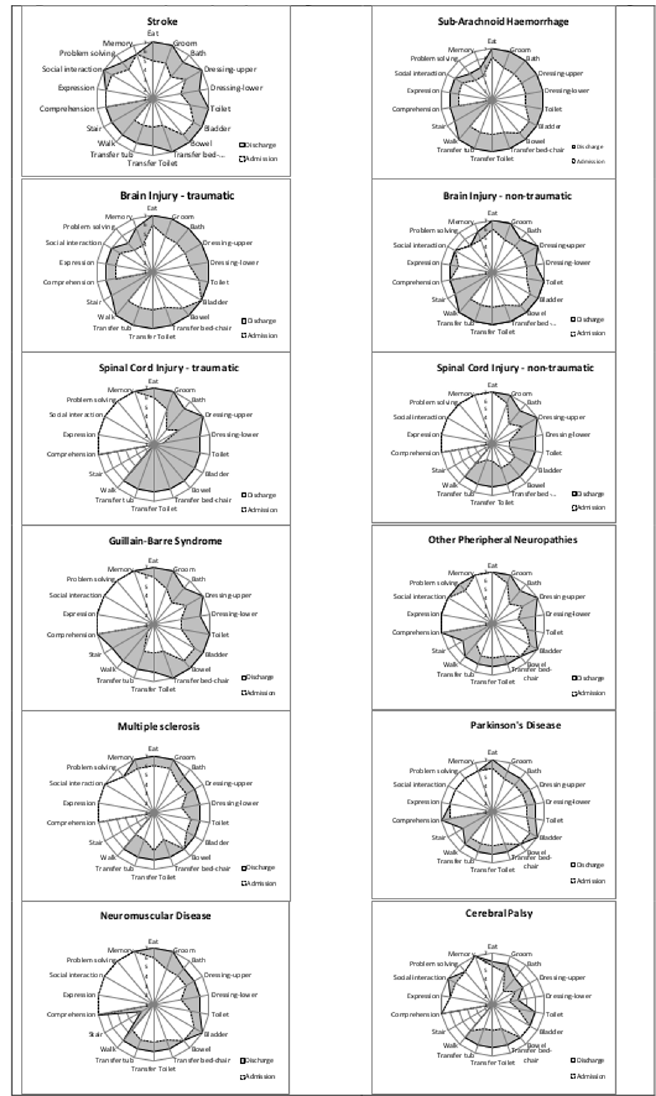
Fig 2. Radar Charts (FIM-Splats) showing median FIM scores on admission and discharge for the 12 groups. The FIM-Splat provides graphic presentation of the disability profile in a radar chart. The 18 items are arranged as ‘ spokes of the wheel ’ and the Levels from 1 (total dependence) to 7 (total independence) run from the centre outwards. Thus a perfect score would be demonstrated as a large circle. The group median scores for each item are plotted for admission and discharge. The difference between median scores on admission and discharge is depicted by the shaded area.